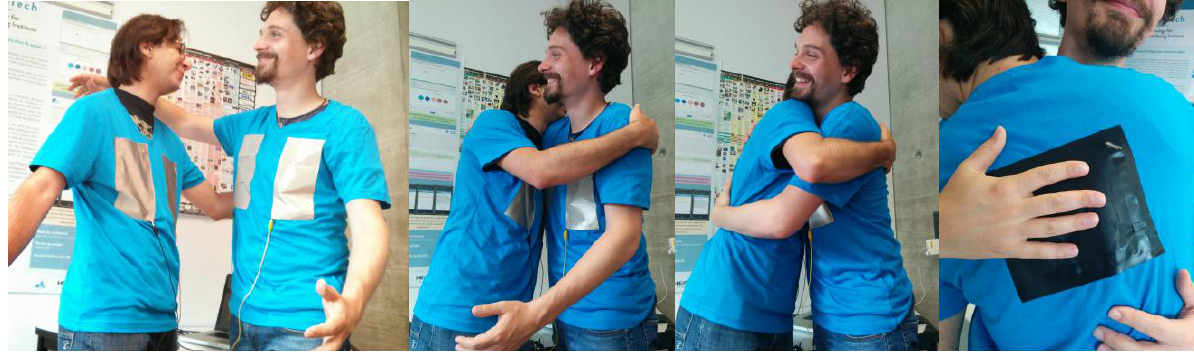
Figure 12. The hug gesture for the Hugginess